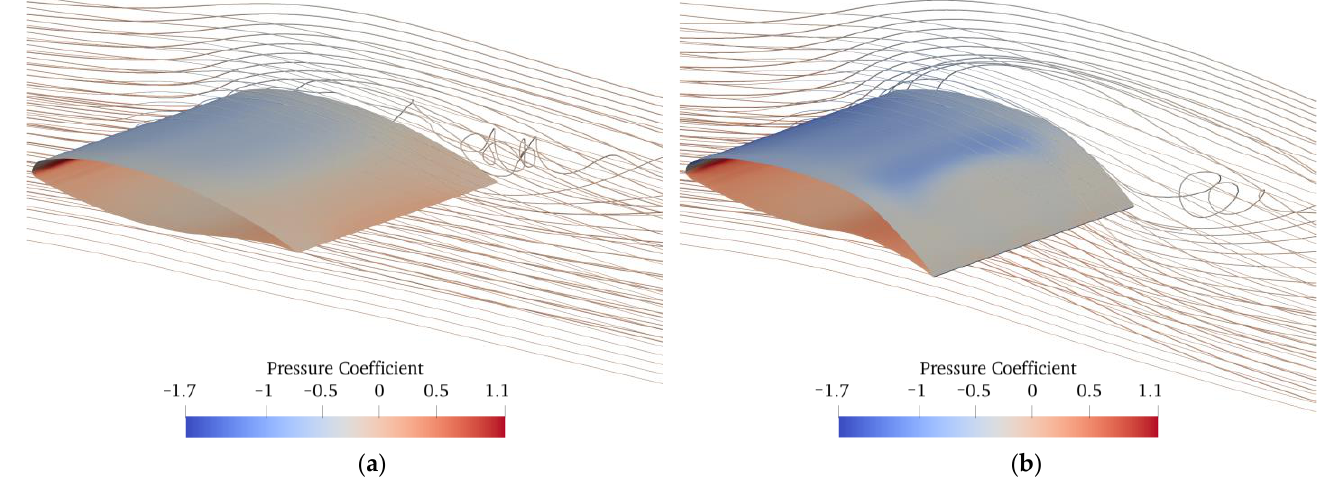
Figure 17. Pressure coefficient distributions and streamlines of the undeformed and deformed wing (with 15° downward deflection) at a 5° angle of attack. ( a ) Undeformed wing. ( b ) Deformed wing.